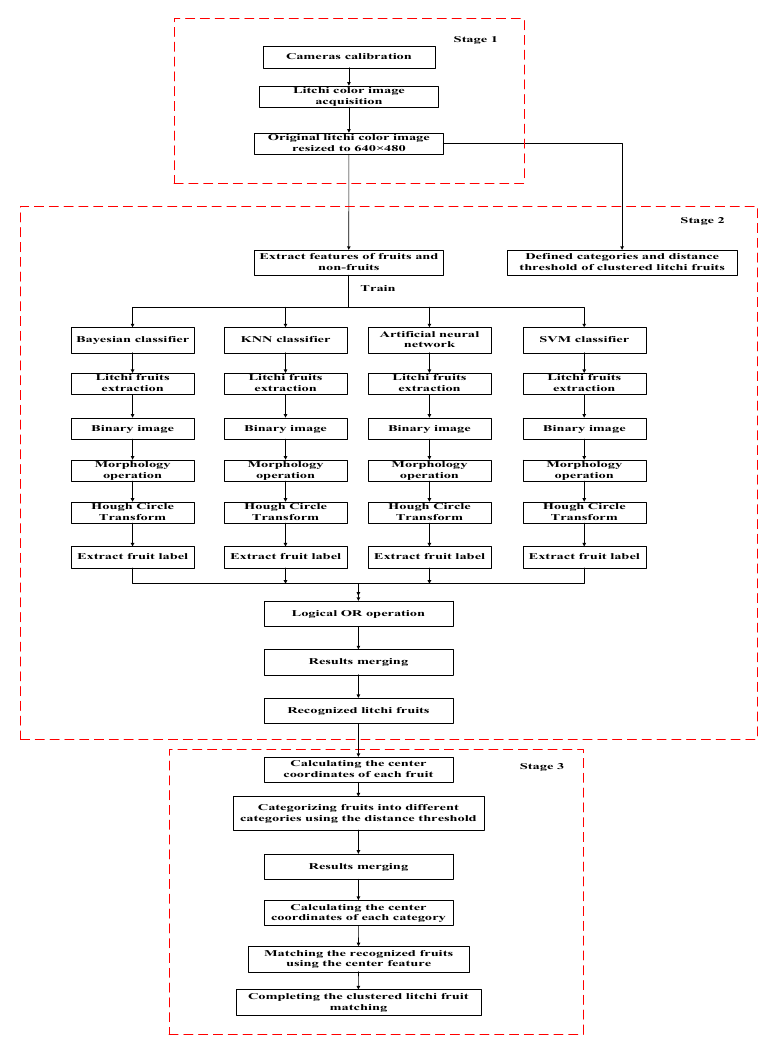
Figure 2. Flow chart of the proposed algorithm.